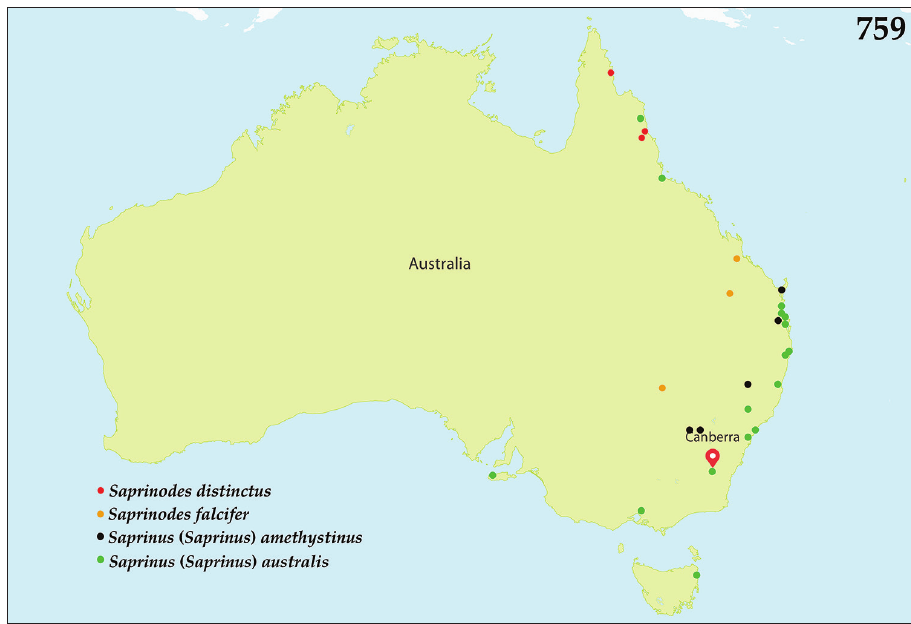
Figure 759. Distribution of Saprinodes distinctus Dégallier, 1993; Saprinodes falcifer Lewis, 1891; Saprinus ( Saprinus ) amethystinus Lewis, 1900 and Saprinus ( Saprinus ) australis (Boisduval, 1835) in Australia.